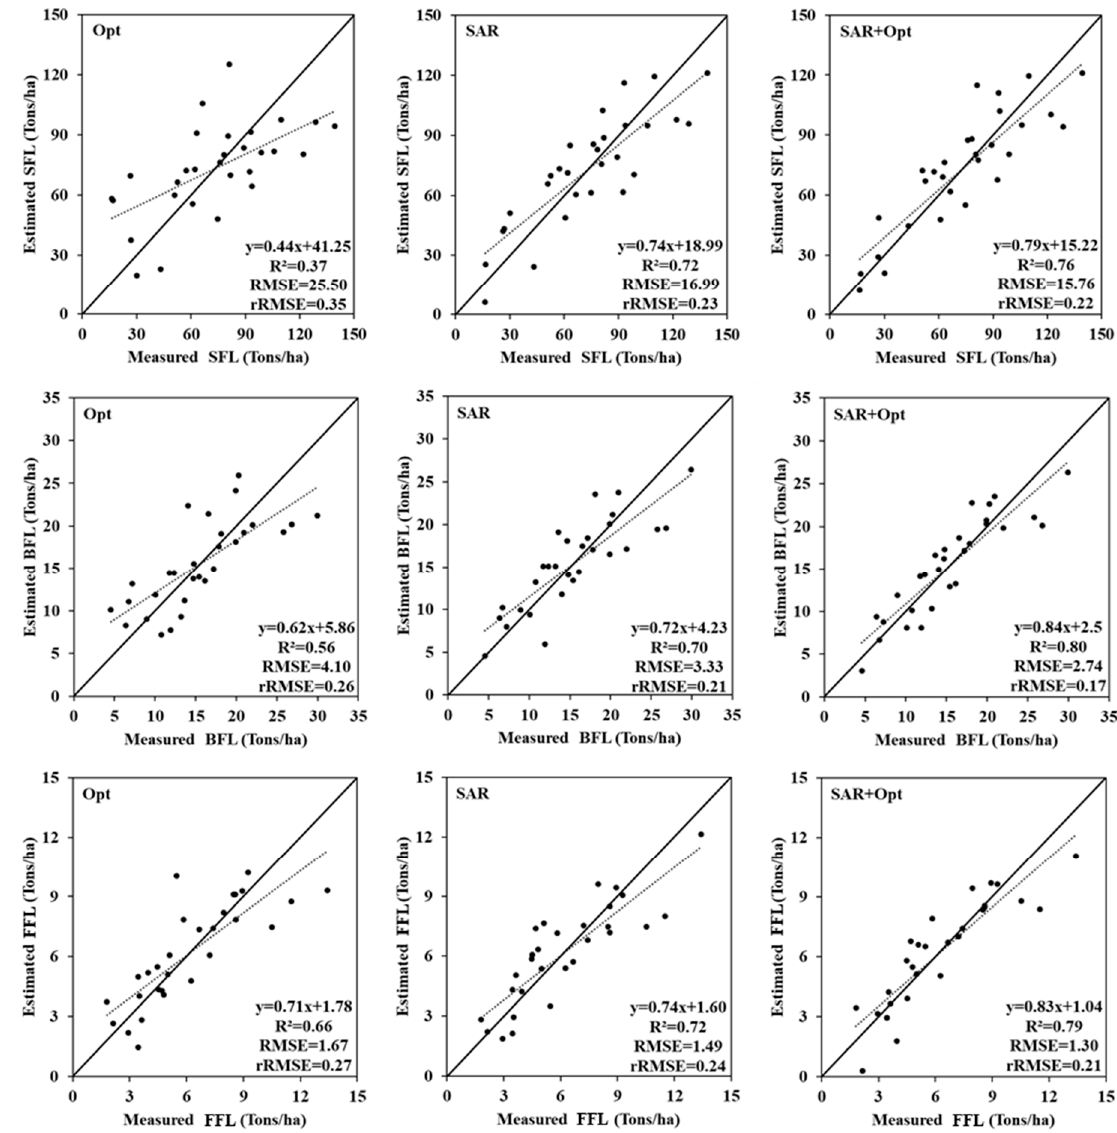
Figure 5. Scatterplot of estimated fuel load vs. measured fuel load. From top to bottom are SFL, BFL, FFL, and from left to right are Opt, SAR, SAR + Opt.